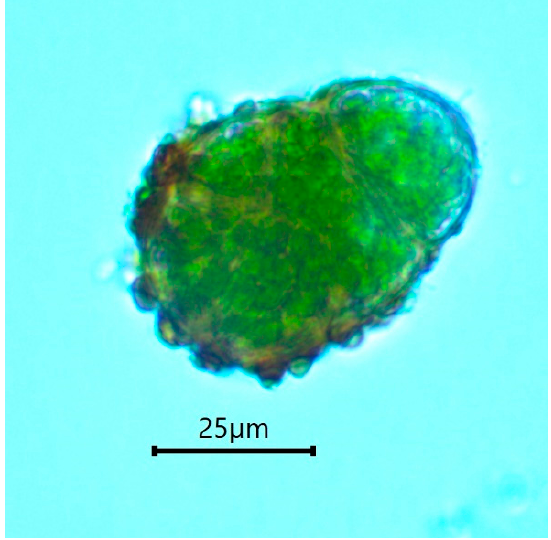
Figure 5. Buxbaumia viridis gemma.